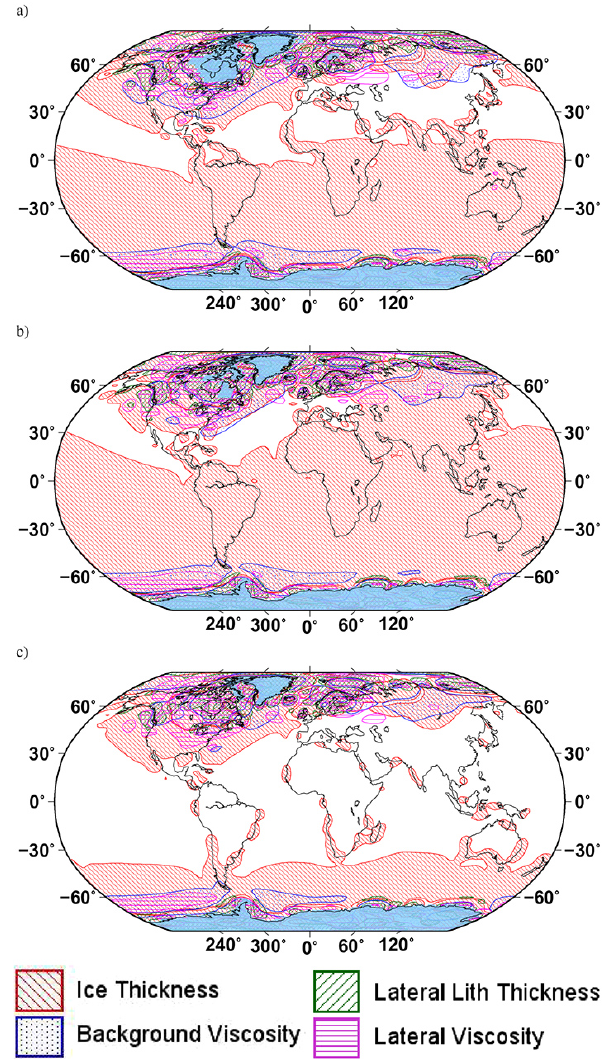
Figure 5. Sensitivity of relative sea-level data around the world above an assumed error of 2m to changes in ice-load history model (see text, red area, lines from top left to bottom right), lithospheric thickness variations (green, lines from top right to bottom left), background viscosity (blue dots), and lateral viscosity variations (pink, horizontal lines) at (a) 18, (b) 14 and (c) 12ka. If a color does not appear, then the sensitivity of this parameter lies below the error. Light blue areas mark the extent of ice sheets at the time, taken from the ICE-5G model (Peltier, 2004).